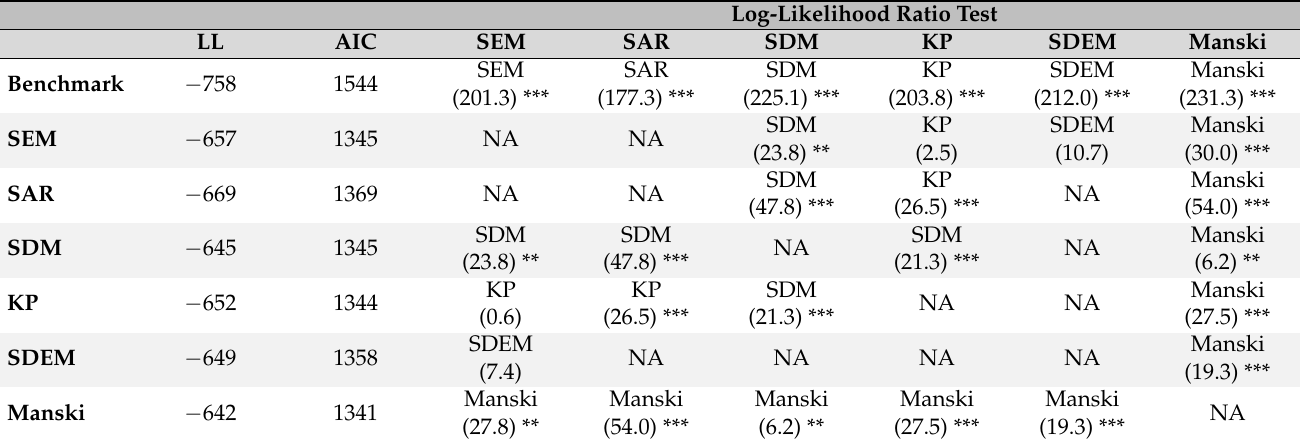
Table 3. Spatial Model Specification Tests for the Saenuri Party Voting